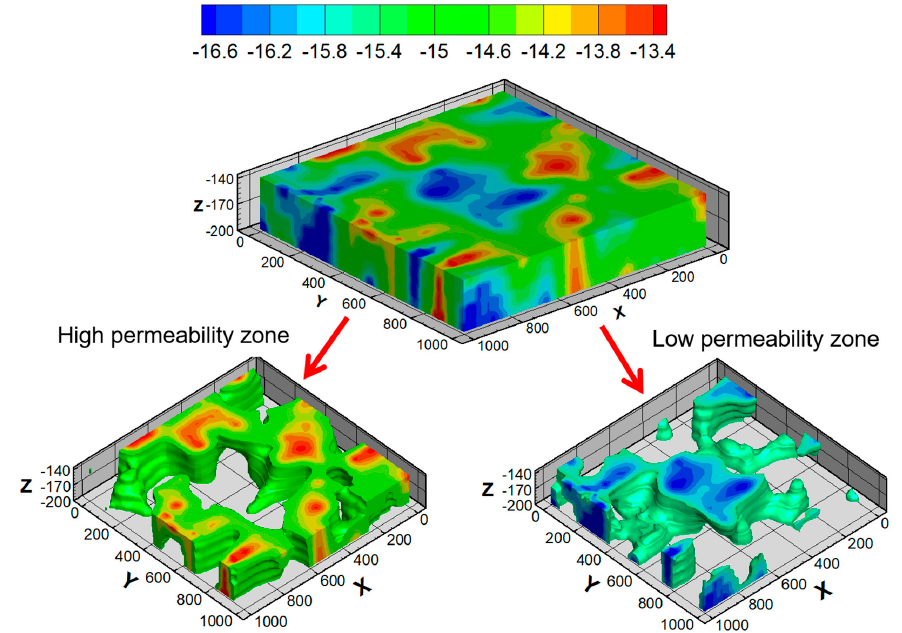
Figure 5. Permeability distribution of a hydrate reservoir with spatial heterogeneity.